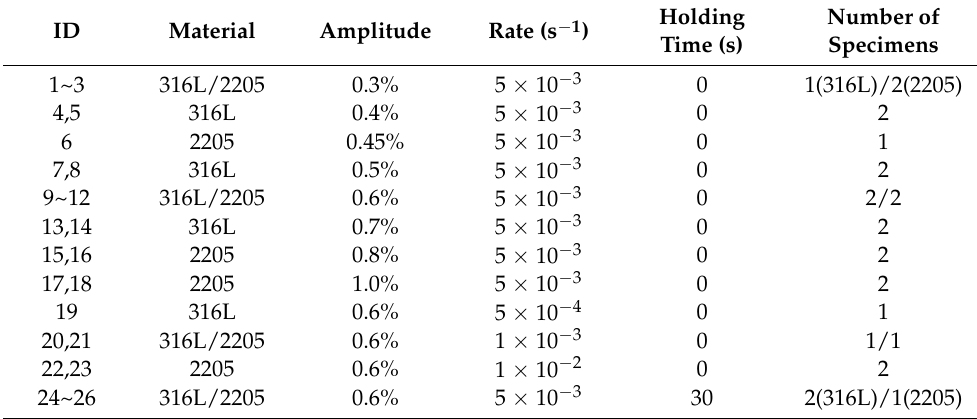
Table 2. Experimental details for all LCF